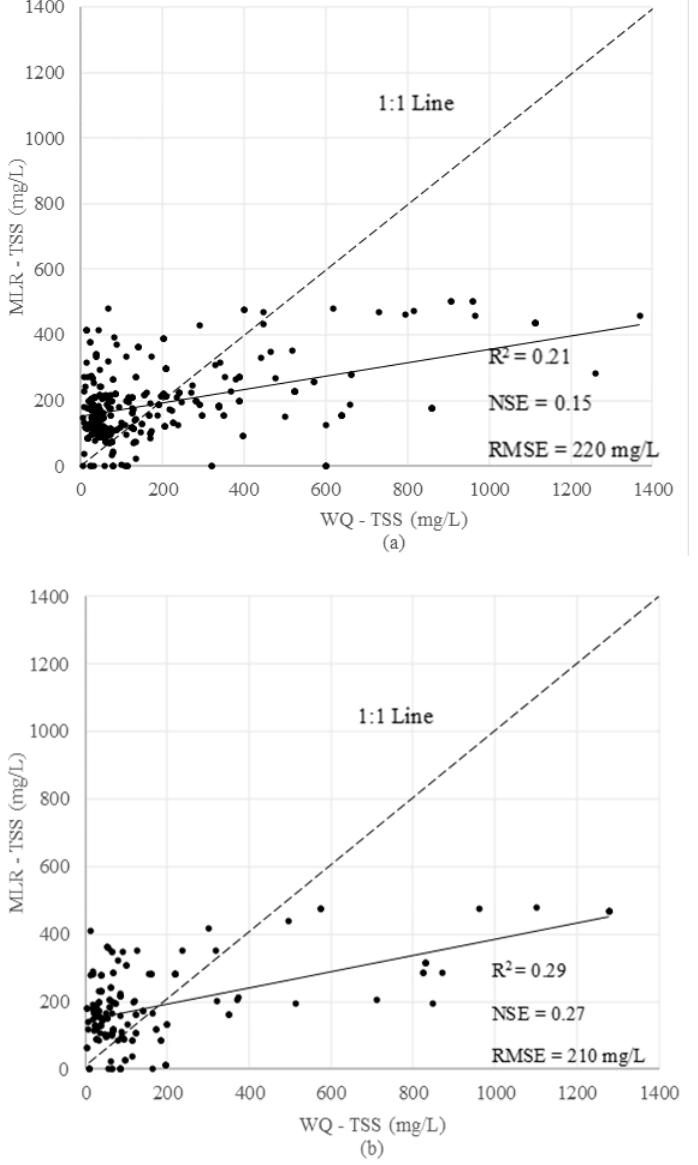
Figure 2. Correlation between the measured values and Multiple Linear Regression (MLR)-predicted Total Suspended Solids (TSS) concentration in ( a ) the training step and ( b ) the prediction step.